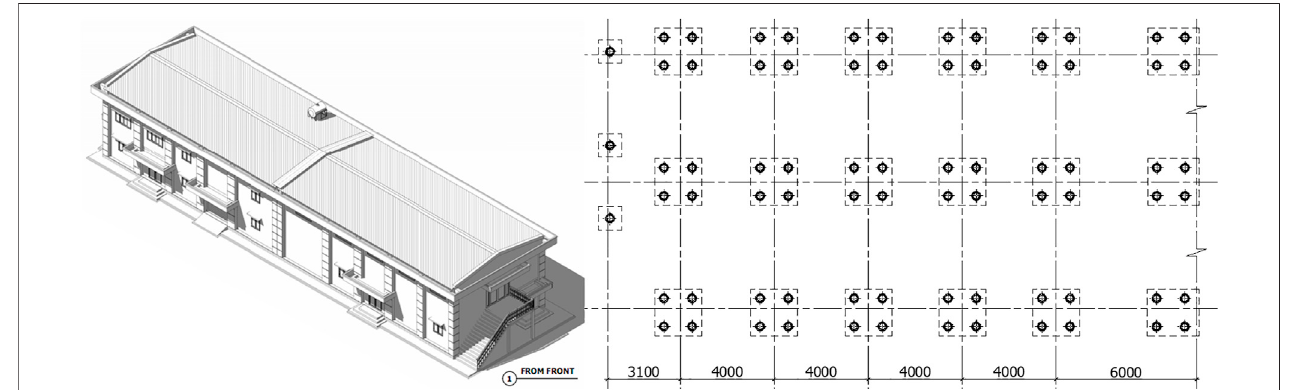
FIGURE 1 | Descriptions of the control building and the layout of the PHC